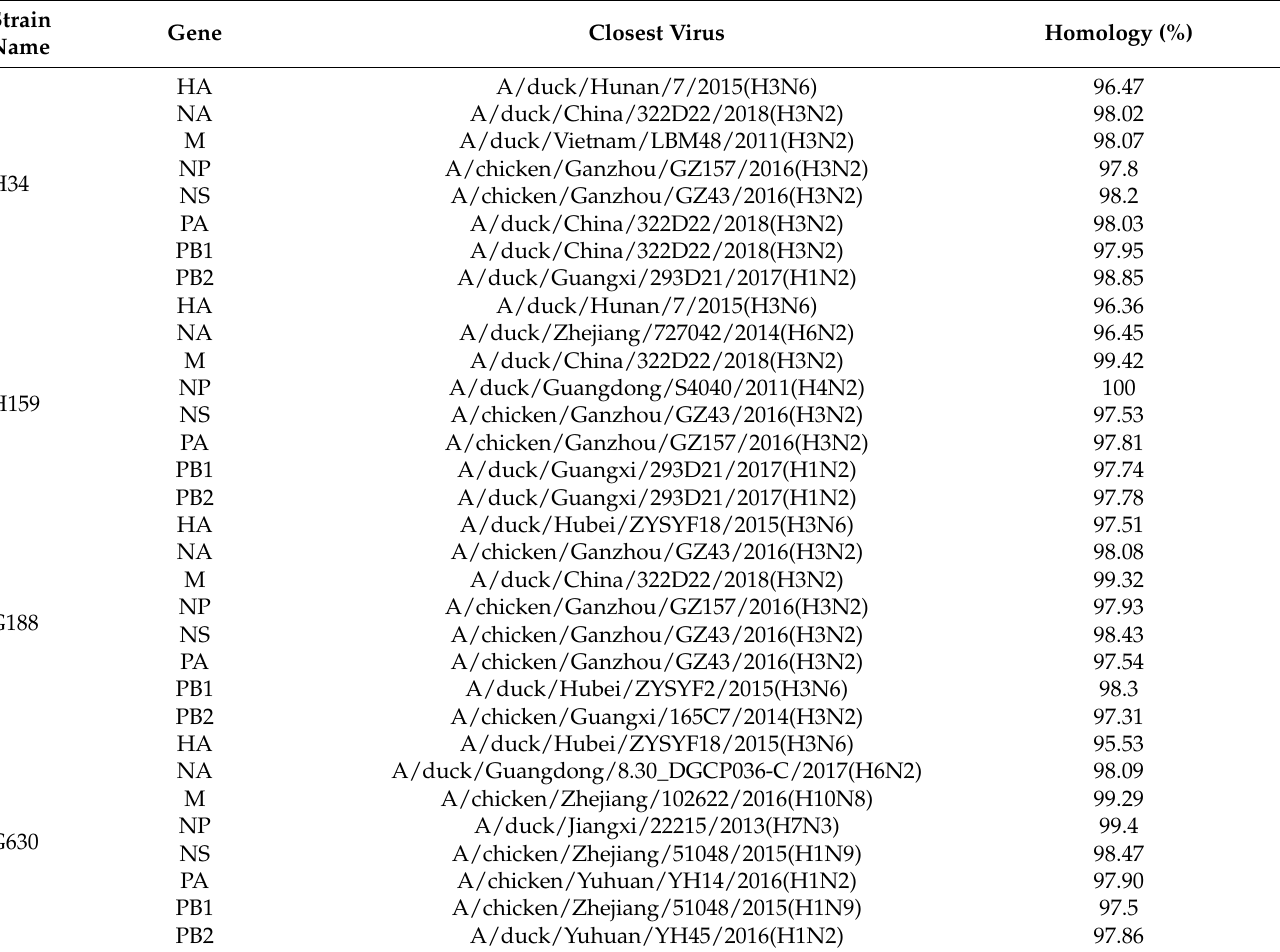
Table 1. Virus strains with the highest homology of each gene segment of the four laboratory